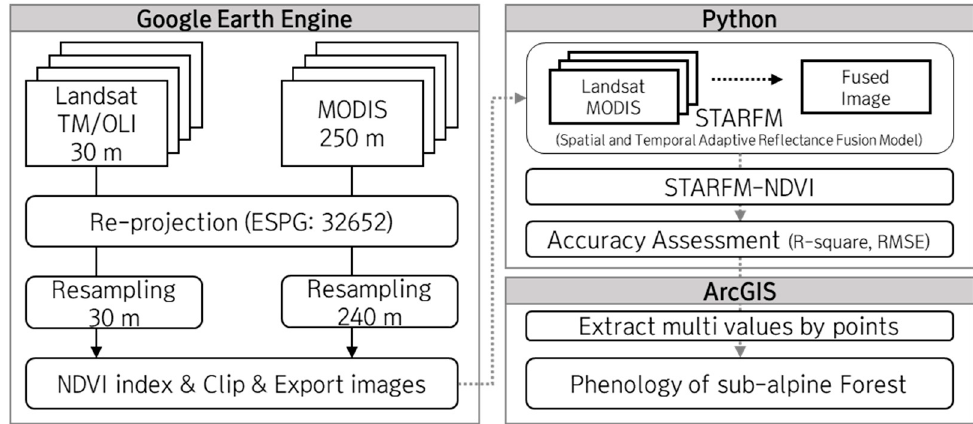
Figure 2. Data processing workflow.